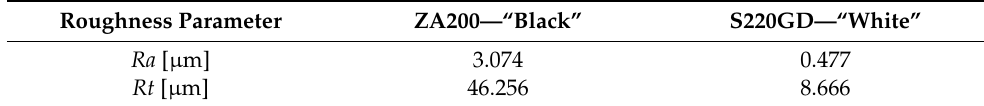
Table 2. Findings for the coating surface roughness profile tests.